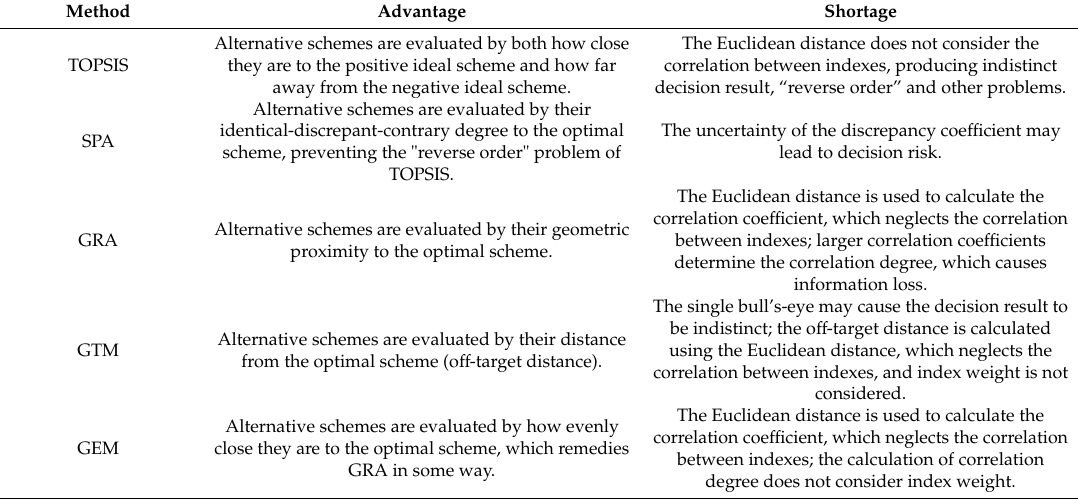
Table 1. Comparison of the five multi-attribute decision-making